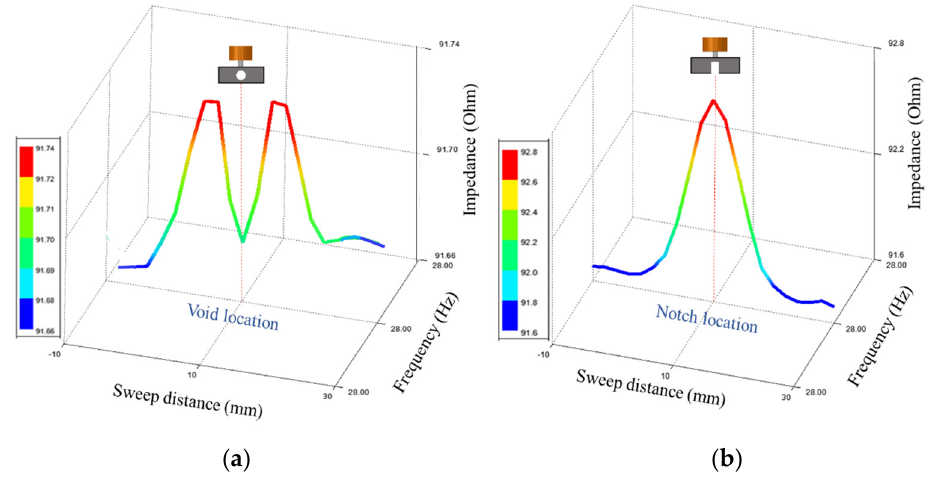
Figure 5. Shows simulation results of the probe impedance change on top of a plate with a defect at 10 mm, where ( a ) defect type is a sphere, ( b ) defect type is a